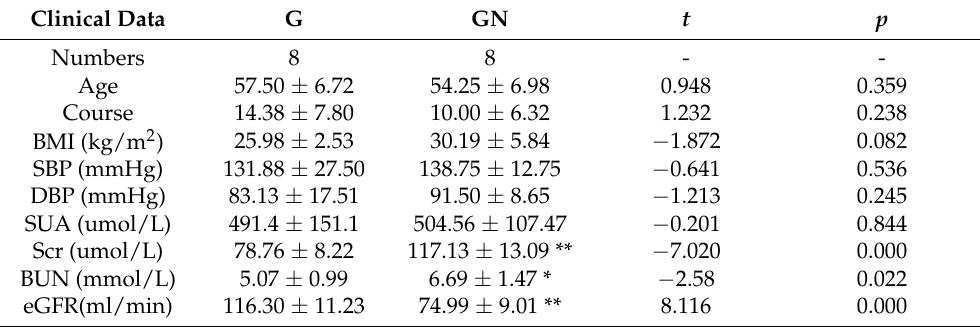
Table 2. Comparison of clinical data between gout alone and gout with renal injury ( x ±